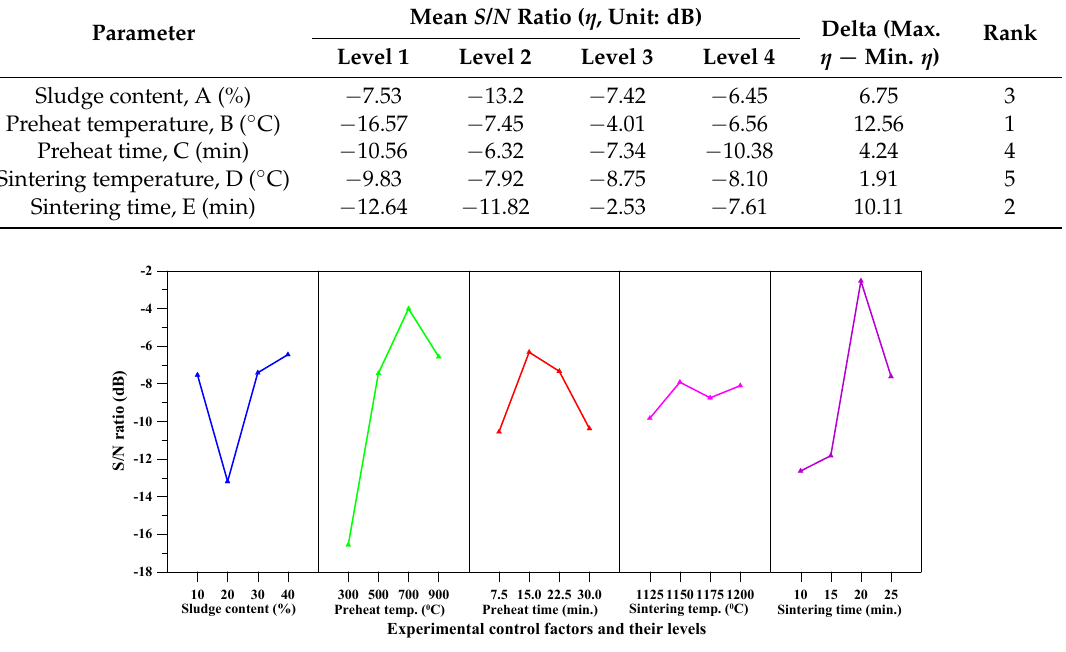
Figure 4. S / N response graph for water absorption. Table 8. S / N response table for water absorption.